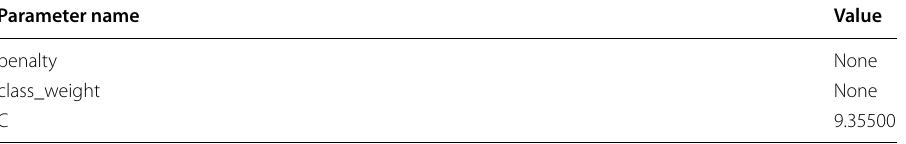
Table 72 Modes of LR tuned hyperparameter values for experiments with the information theft